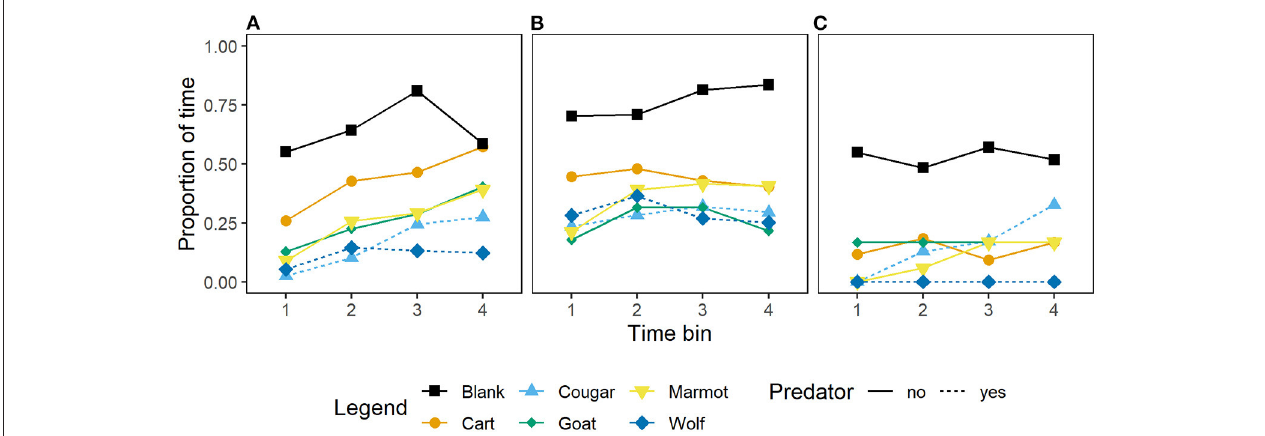
FIGURE 4 | Mean proportion of time by 15s time bin that Vancouver Island marmots ( n = 34) allocated to foraging in response to various mammal stimuli and while a blank was scored. Panels from left to right; (A) Wild-caught ( n = 17), (B) captive-born 1st and 2nd generation ( n = 11), and (C) captive born 3rd, 4th, and 5th generation ( n =